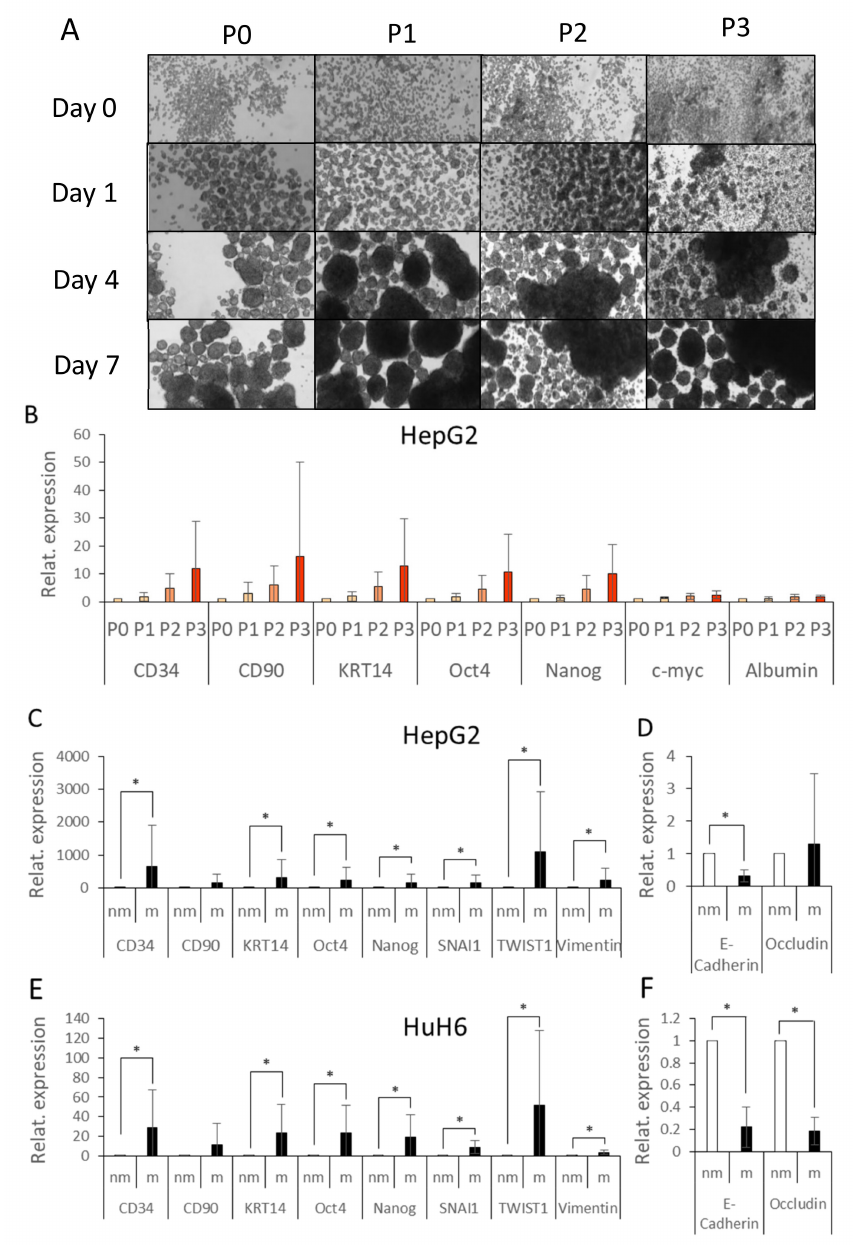
Figure 3. CD34 + CD90 + OV-6 + csVimentin + cells formed tumorspheres and migrated at a higher rate. ( A ) Tumorspheres of HepG2 cells were grown and passaged three times (P0–P3). ( B ) After 7 days of incubation, the gene expressions of CD34, CD90, KRT14 (one of the antigens of the OV-6 antibody), Oct4, Nanog, c-myc and albumin were measured by qPCR. The values of P0 were normalized to 1 and the fold changes of P1, P2 and P3 were calculated accordingly. The columns represent the mean with error bars depicting the standard deviation from the mean. The experiment was repeated 4 times. Dunn’s multiple comparisons test was performed in order to calculate the significance of the data. ( C – F ) HepG2 and HuH6 cells were seeded into a cell culture insert with a membrane containing media without FBS and placed into wells with media with FBS. After 24 h, the expressions of CD34, CD90, KRT14, Oct4, Nanog, SNAI1, Twist1, vimentin, E-cadherin and occludin were measured of the non-migrated (nm) and the migrated (m) cells using qPCR. The values of the non-migrated cells were normalized to 1 and the values of the migrated cells were calculated in relation to the non-migrated cells. The columns represent the mean with error bars depicting the standard deviation from the mean. The experiment was performed 4 times. A two-tailed Wilcoxon signed-rank test was performed in order to calculate the significance of the data (* p <